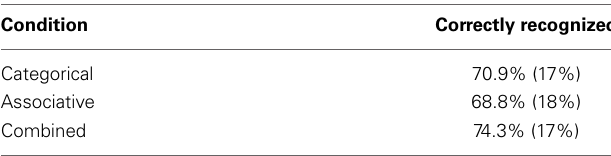
Table 3 | Accuracy of lexical decision task, by condition (categorical, associative,